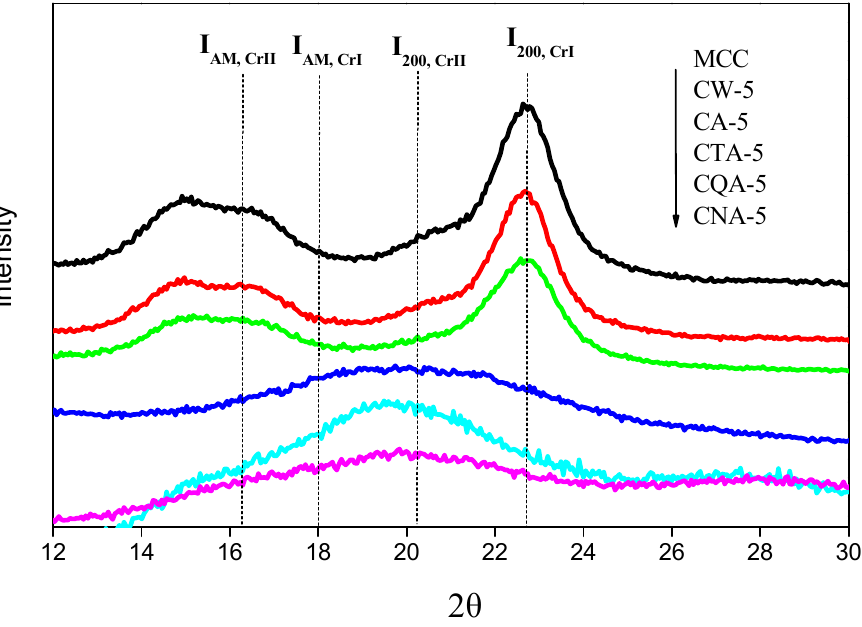
Figure 2. X-ray diffraction patterns of original cellulose and regenerated samples. Table 2. Crystal phase and crystallinity index of cellulose samples prepared from different solvents. Sample